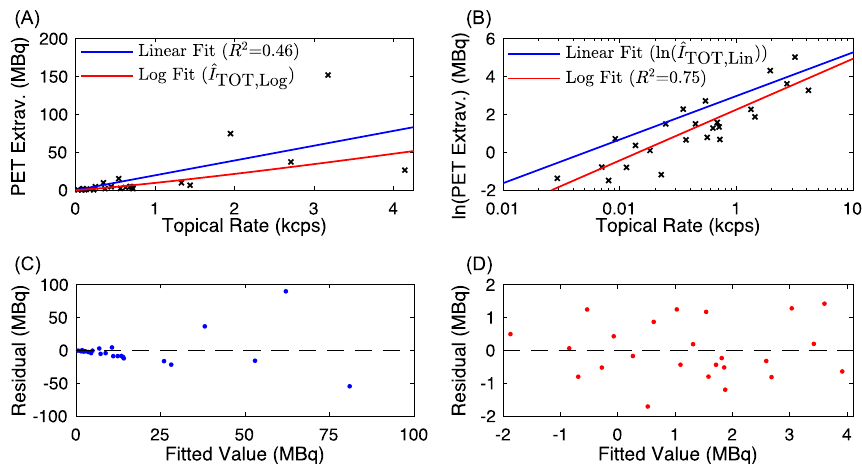
Fig. 4 Correlation analysis of ground truth PET image extravasations ( I TOT ) versus extrapolated difference in topical detector count rates ( ˆ D ). Both linear and log fits, as detailed in (3) and (4), are shown. Plots depict ( A ) original and ( B ) log-transformed axes, with measured data denoted by black "x" marks. Residual fits for the ( C ) linear and ( D ) log fits, with zero residual marked by the dashed black